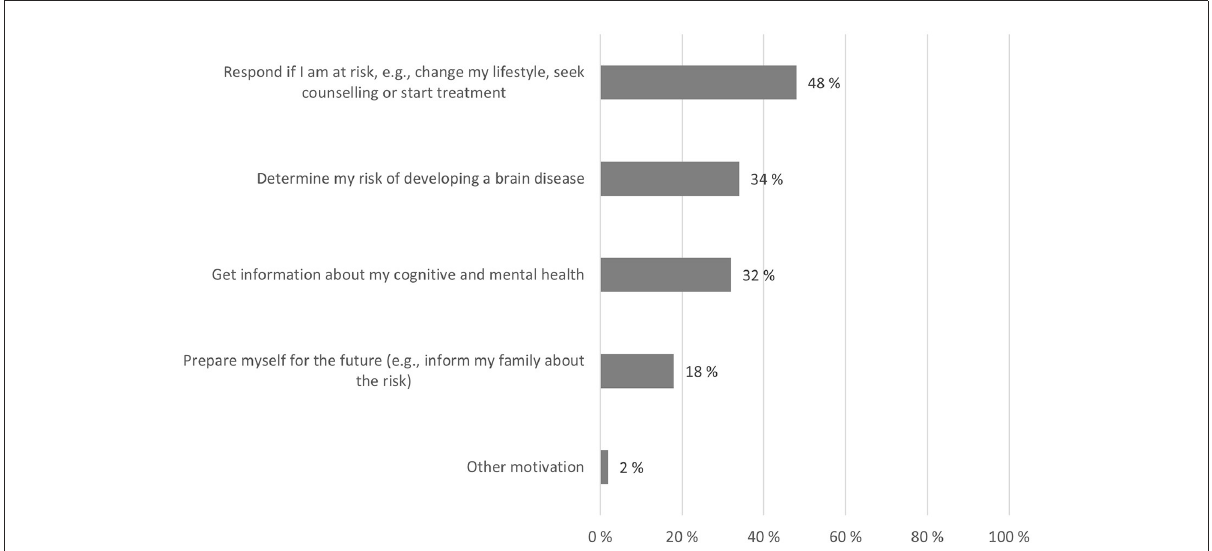
FIGURE2 Reasons for taking a brain health test. Respondents who answered they would take a brain health test could select up to two most important reasons for doing so. Percentages indicate the proportion of respondents who chose each reason (percentages exceed 100% in total because respondents could choose up to two